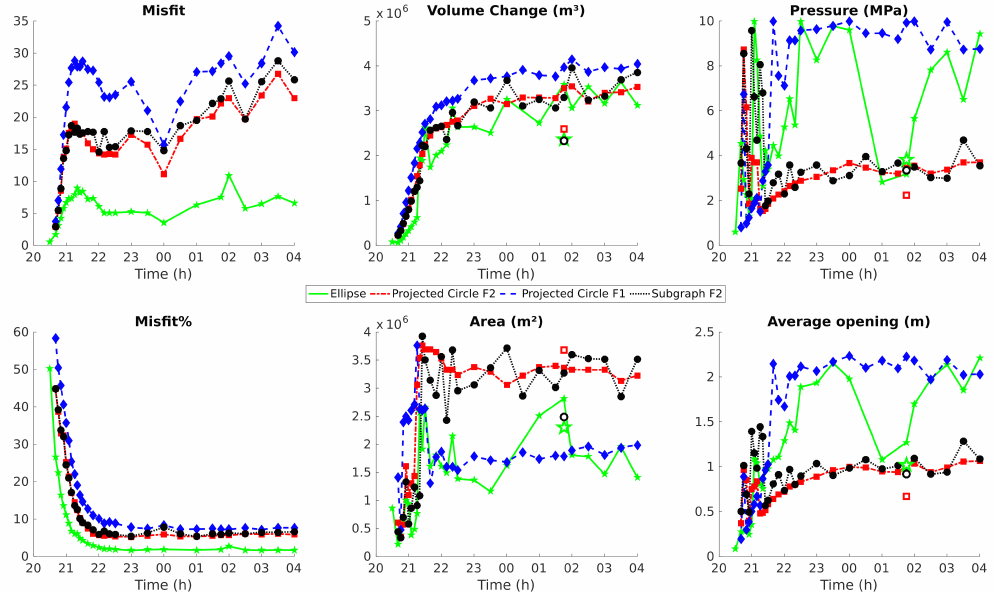
Figure 11. Results of inversions of the GNSS time series for 29 time steps between 20:40 and 4:00 a.m. Green line is the Ellipse method. Blue and red dashed lines are the Projected Disk method on a priori meshes for families F1 and F2, respectively. Solid black circles are the Subgraph method for family F2. Open symbols are for inversions from the intermediate Sentinel-1 interferogram S1 D1, green star corresponds to the Ellipse method, red square to the Projected Disk on family F2 and black circle to the Subgraph method on family F2. Note that for all methods, increase in the misfit between 20:40 and 21:30 is due to the increase in the amplitude of measured displacements as shown by the sharp decrease of the relative misfit in percent Equation